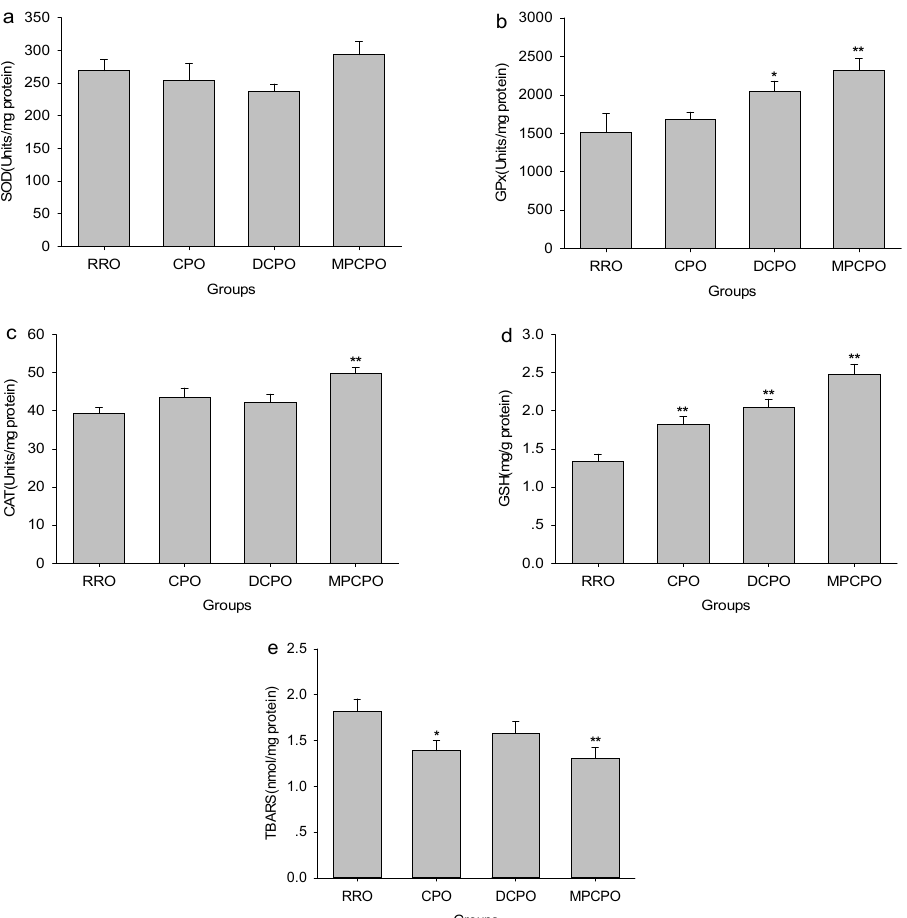
Figure 5. Effects of optimized rapeseed oils (OROs) on hepatic superoxide dismutase (SOD) (a), glutathione peroxidase (GPx) (b) and catalase (CAT) (c) activities as well as glutathione (GSH) (d) and thiobarbituric acid reactive substances (TBARS) (e) contents in rats fed a high ‐ fat diet. RRO: the